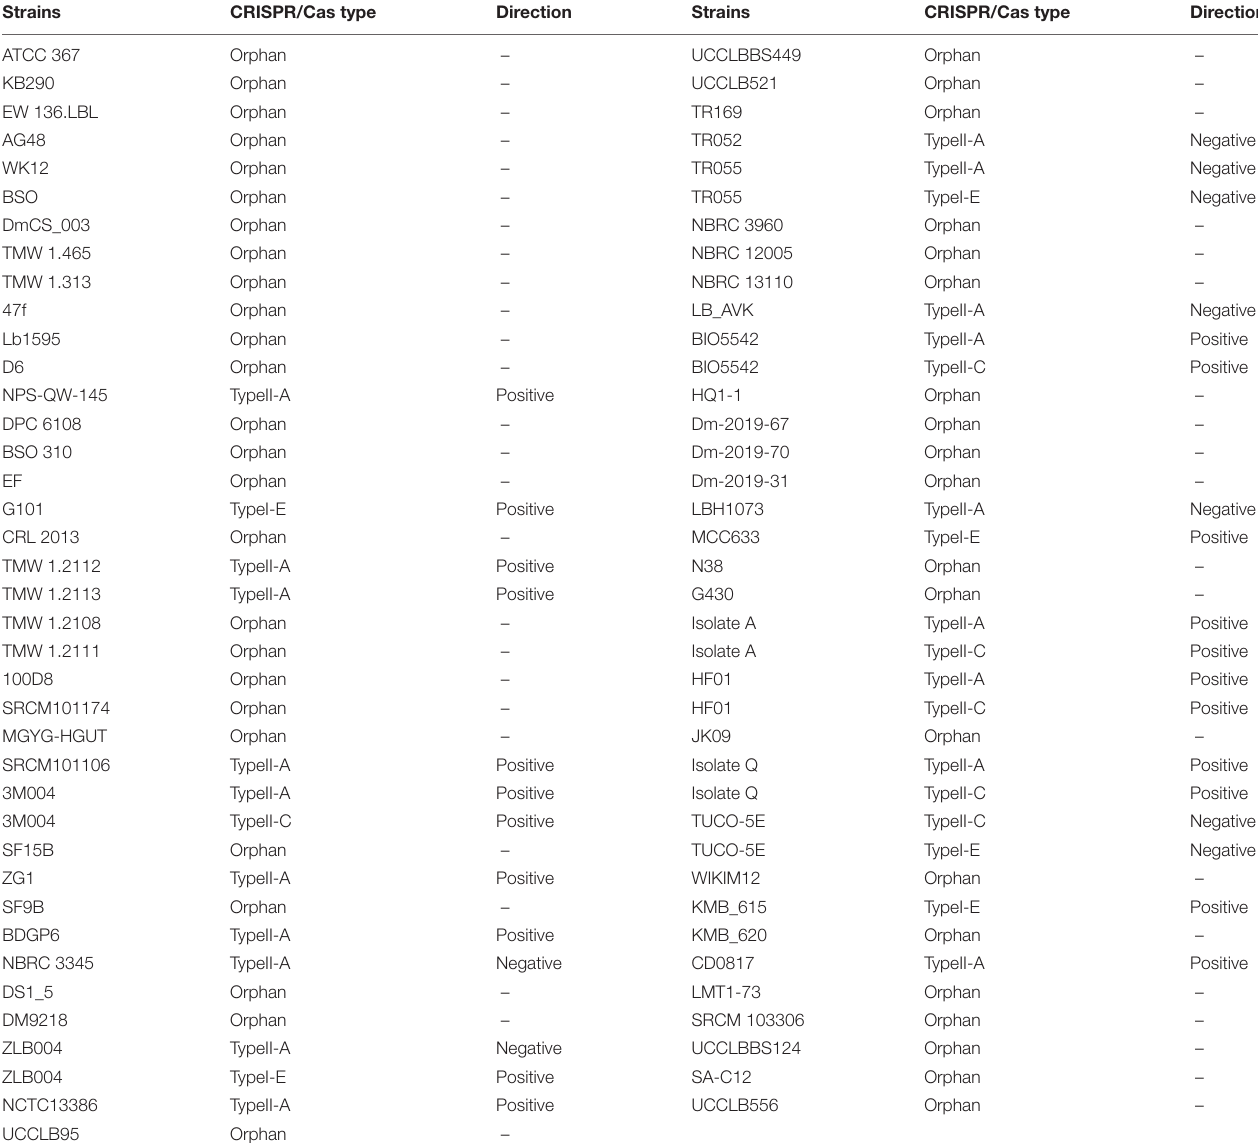
TABLE 1 | Clustered regularly interspaced short palindromic repeats/CRISPR-associated system in L. brevis strains with confirmed CRISPR array.